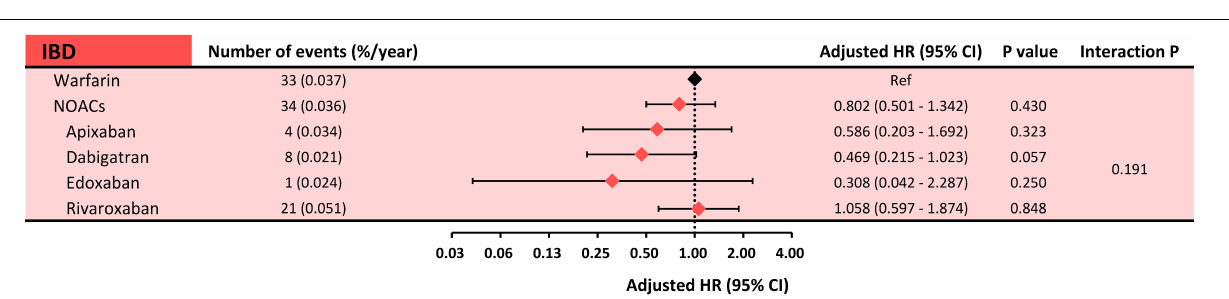
FIGURE 3 | Subgroup analysis: risk of ischemic bowel disease between each NOAC and warfarin. Subgroup analysis showed a comparable risk of ischemic bowel disease between each NOAC and warfarin. The interaction p- value was 0.1907. HR, hazard ratio; CI, confidence interval; IBD, ischemic bowel disease; NOACs, non-vitamin K antagonist oral